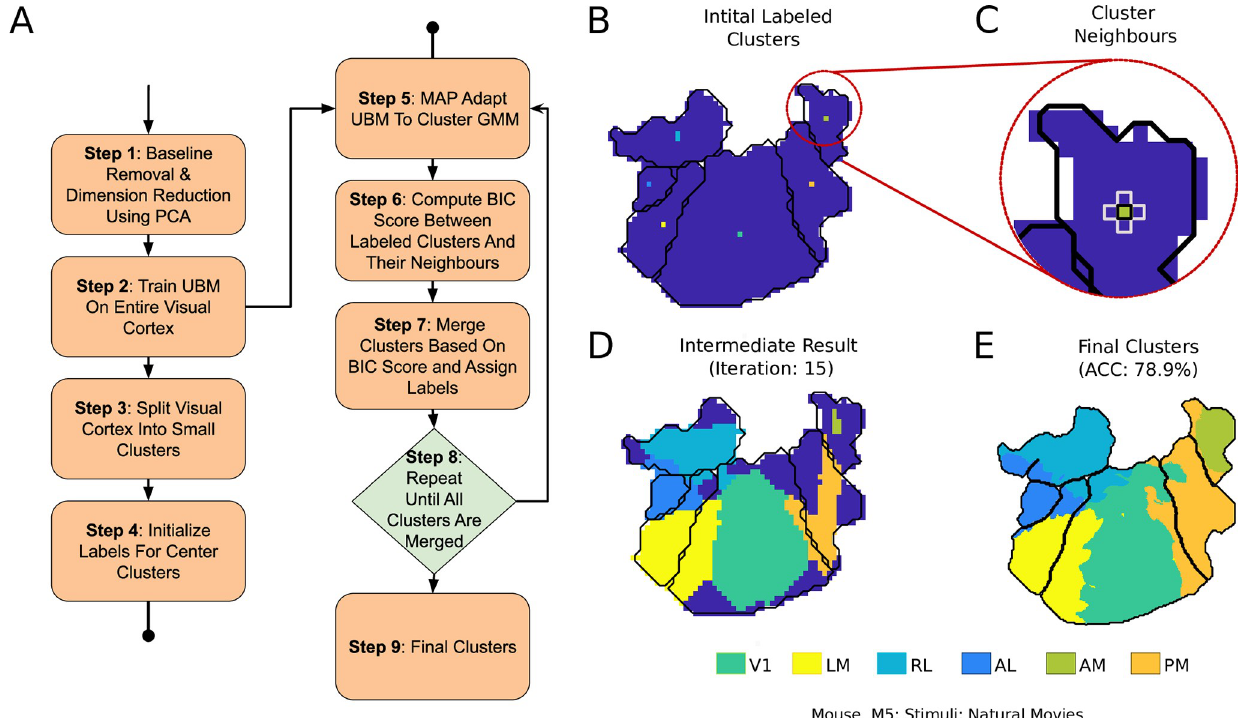
Fig 5. Pipeline for semi-supervised clustering of visual areas. A ) Block diagram of the clustering steps. B ) Initial clusters that are labeled using the retinotopic map. C ) Neighbors of a labeled cluster for area AM . BIC score is computed between these neighbors, and closest few are merged every iteration. D ) An intermediate step in the clustering process. E ) Final clustering result with accuracy